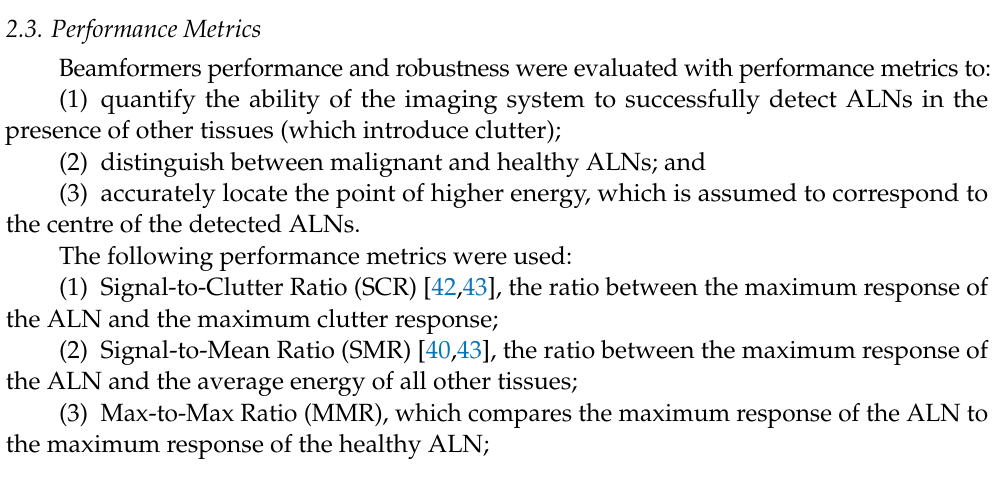
Figure 2. Diagram of the monostatic Channel-Ranked Delay-Multiply-And-Sum beamforming algorithm with M = 16